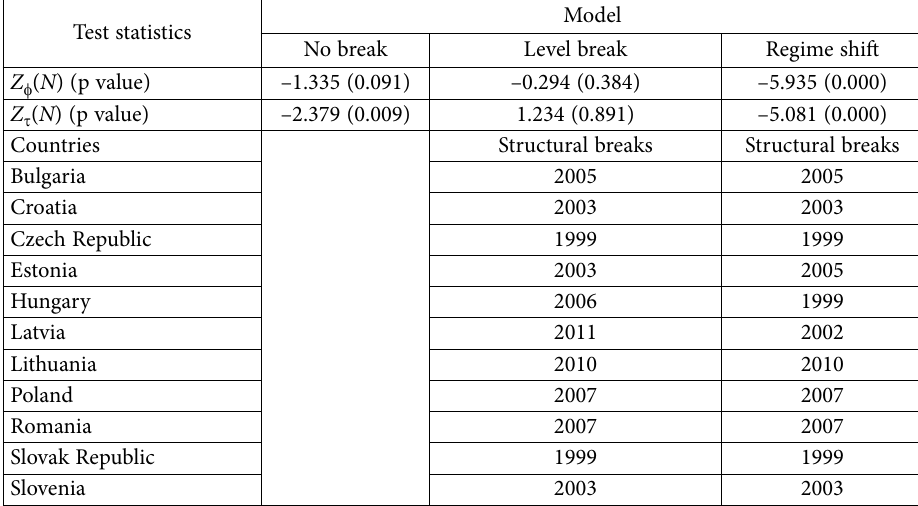
Table 6a. Results of Westerlund and Edgerton’s (2008) cointegration test (Model 1)